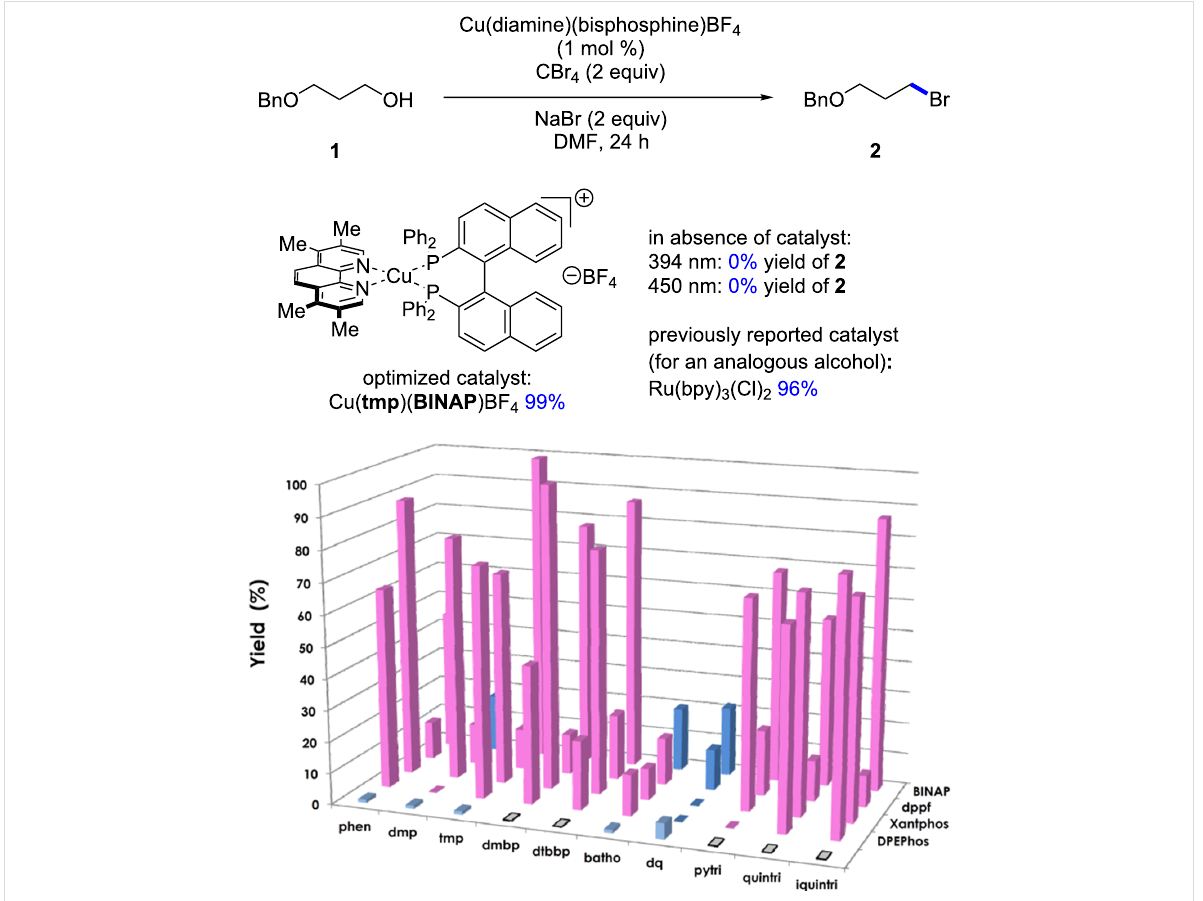
Figure 3: Evaluation of the library of copper-based complexes in photocatalytic alcohol → bromide conversion. Reactions irradiated with 394 nm light (pink) or 450 nm (blue). Front entries without an indicated phosphine ligand pertain to homoleptic Cu(diamine) 2 BF 4 complexes and are colored in lighter blue. Entries without a color indicate reactions which could not be performed due to solubility or overoxidation of the complex.